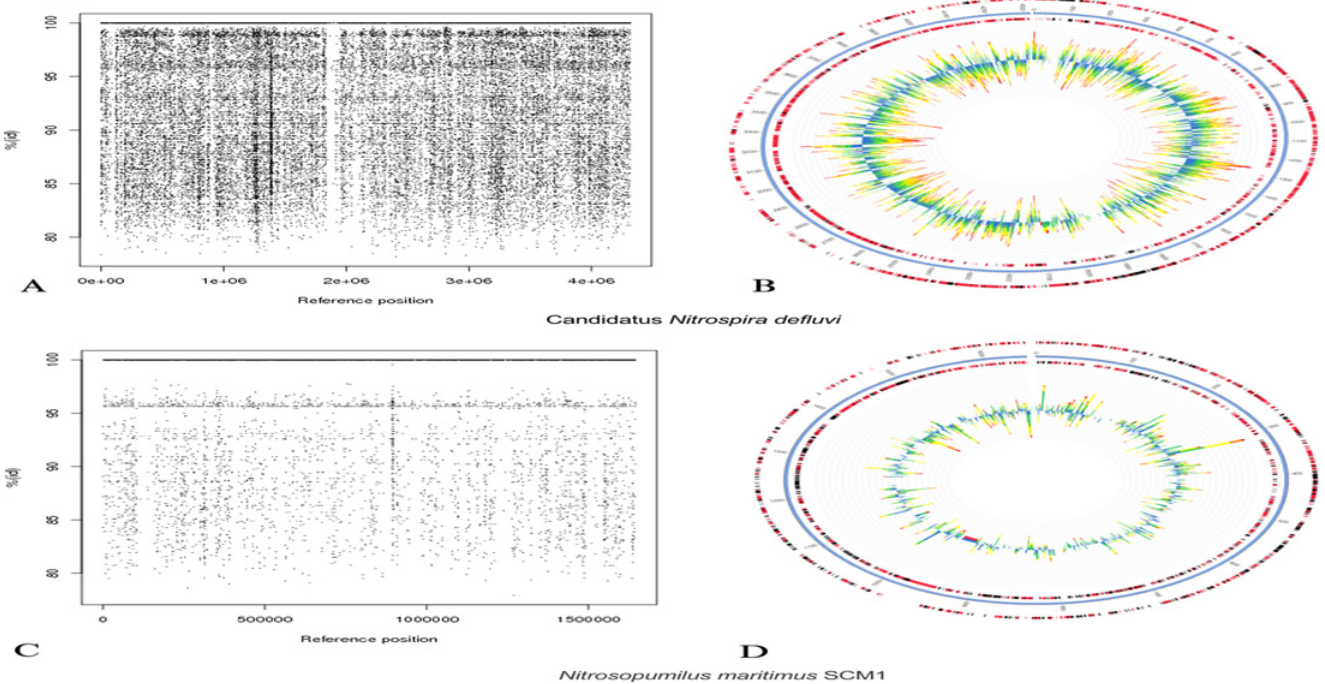
Fig 2. Fragment recruitment plots of the MSS contigs. Candidatus Nitrospira defluvi (A and B — FP929003.1) and Nitrosopumilus maritimus (C and D — CP000866.1). The comparison was made using BLASTn. Vertical axis showed the % identity of the metagenomic contigs to the respective bacterial or archaeal genome. A and C — recruitment by R software; B and D — recruitment by